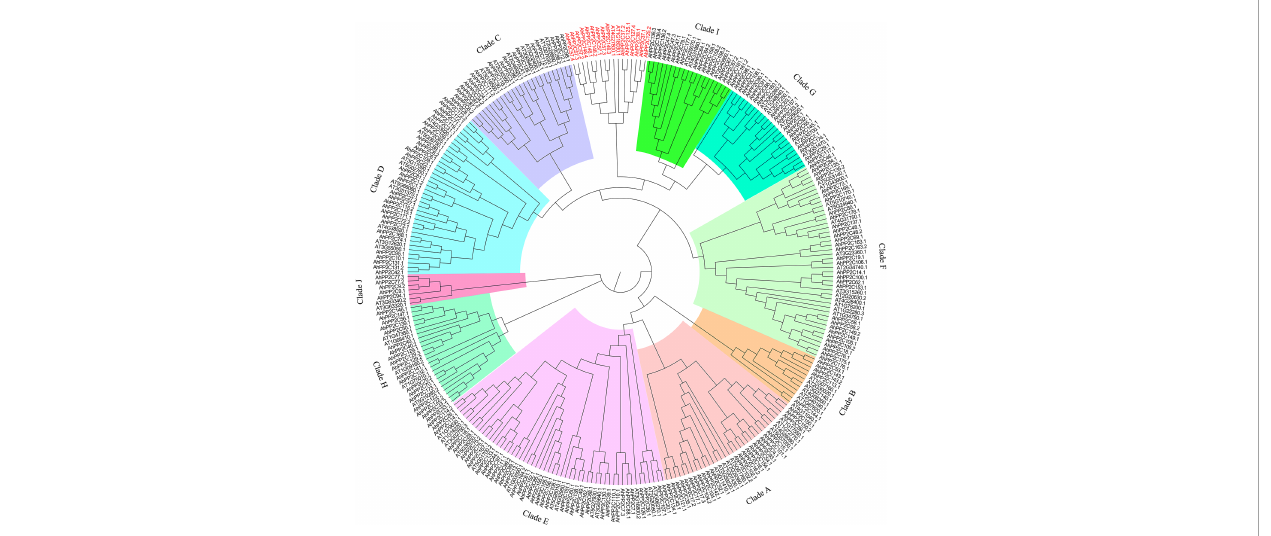
FIGURE 1 A Phylogenetic tree of PP2Cs from peanut and Arabidopsis . PP2Cs in different clades are labeled with different colors. 6 AhPP2C genes in red were not classi fi